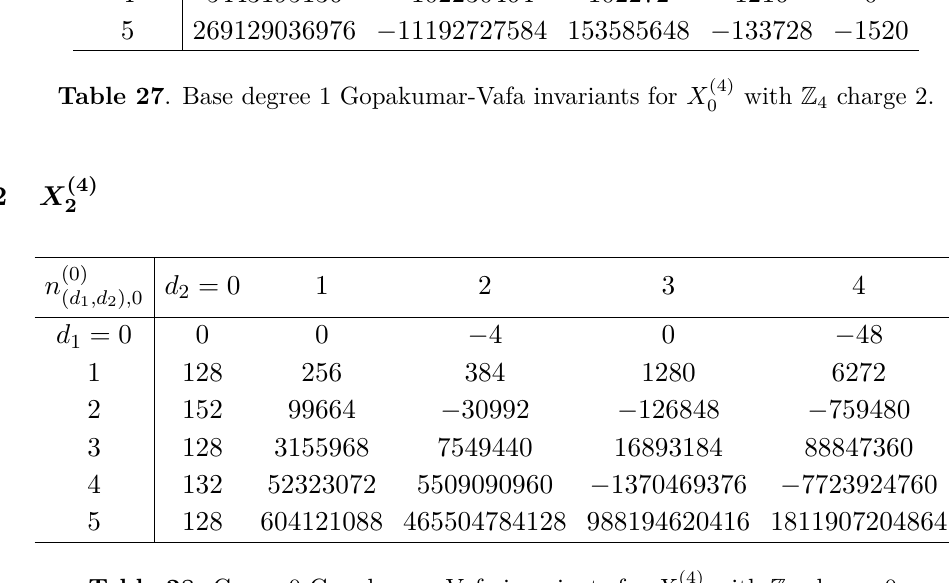
Table 28 . Genus 0 Gopakumar-Vafa invariants for X (4)